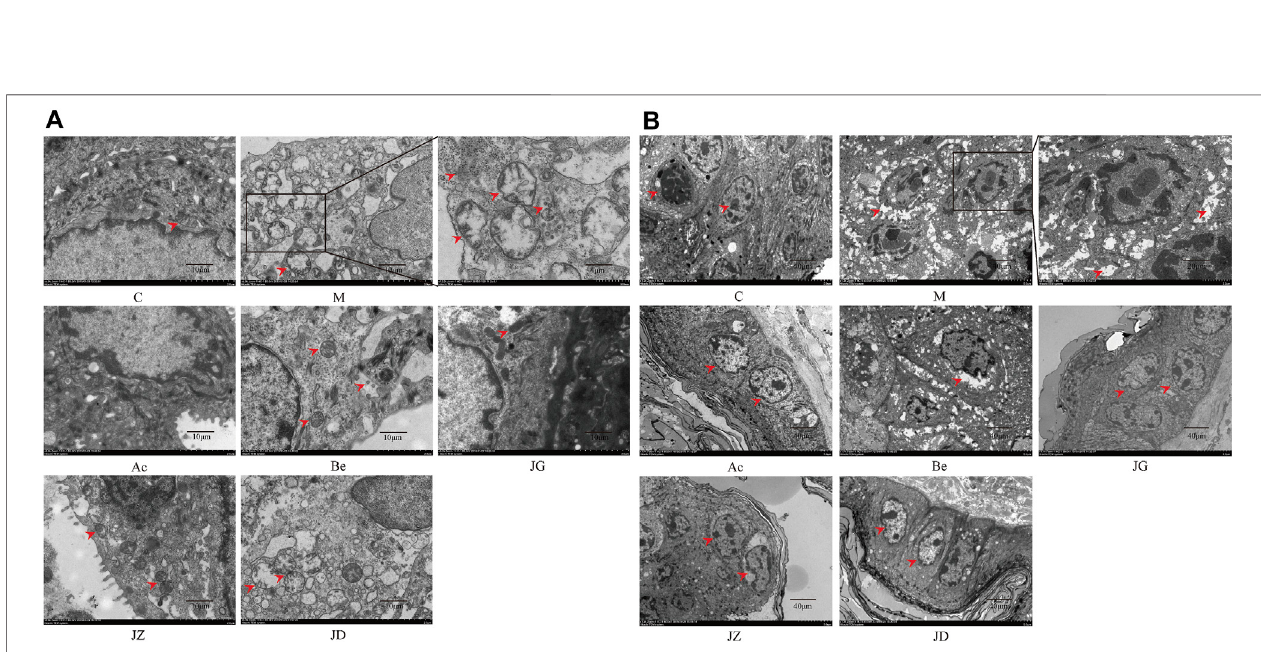
FIGURE7| EffectofJZ-1onultrapathologicalchangesofvaginal (A) andvulvar (B) tissuesinGHmice.Onday9,aftermodeling,thecharacteristicultrapathological changesofvaginal (A) and vulvar (B) tissues in GHmice wereobserved byTEM.JZ-1alleviated pyknosis and intensely stainingofnuclear,reduced theconcentrationof chromatin, spongiosis changes of cytoplasm, and the number of lysosomes and autophagosomes. The arrows in the diagram showed the pyknosis and intensely stainingofnuclear,theconcentrationofchromatin,spongiosischangesofcytoplasm,thelysosomes,andtheautophagosomes.C,controlgroup;M,modelgroup; Ac, acyclovir group; Be, berberine group; JG, JZ, JD: 2.5, 1.5, and 0.5 g/ml JZ-1 group.